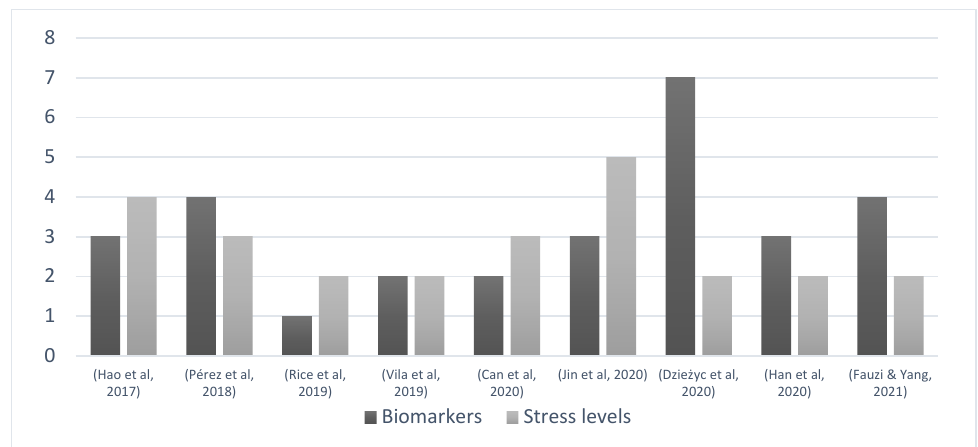
Figure 6. Parameters and stress-level recognition [6,10,20–23,25–27].